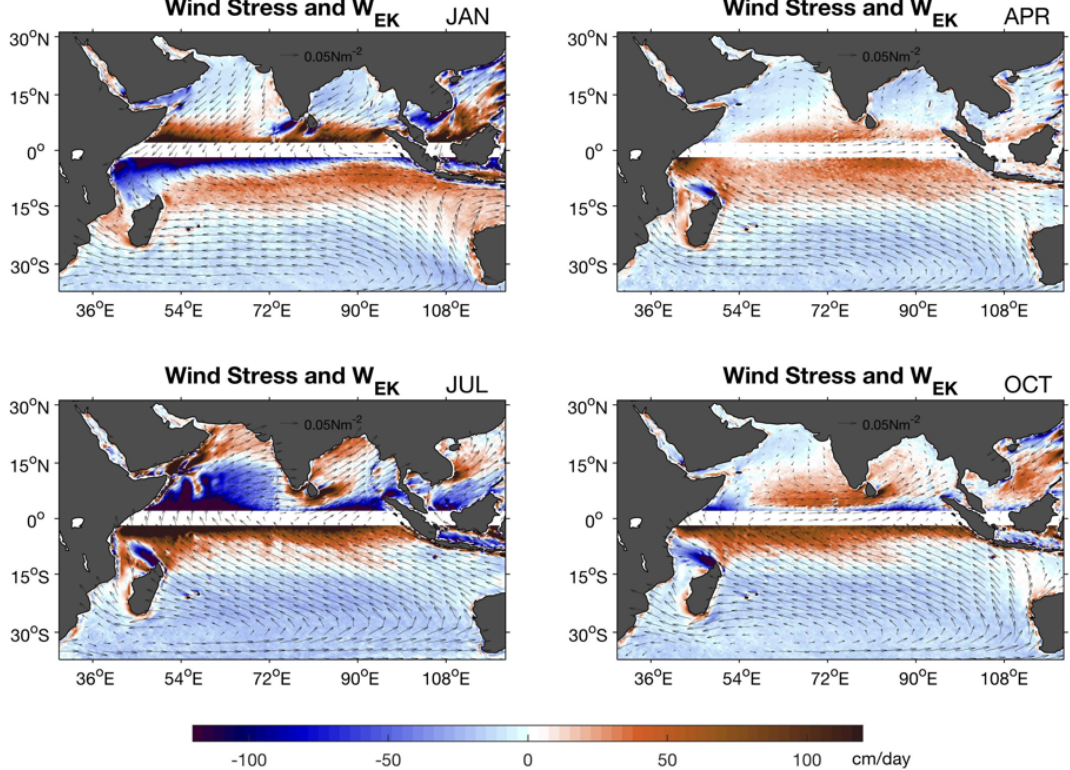
Figure 2. Climatology (2001–2018) of monsoon wind stress (vectors) and Ekman pumping rate (colour shaded) with positive values denoting Ekman suction (upwelling) and negative values Ekman pumping (downwelling) for (a) January – NE monsoon, (b) April – transition, (c) July – SW monsoon, and (d) October – transition. The climatology was constructed by the Objectively Analyzed air–sea Flux High-Resolution (OAFlux-HR) analysis (adapted from Yu,